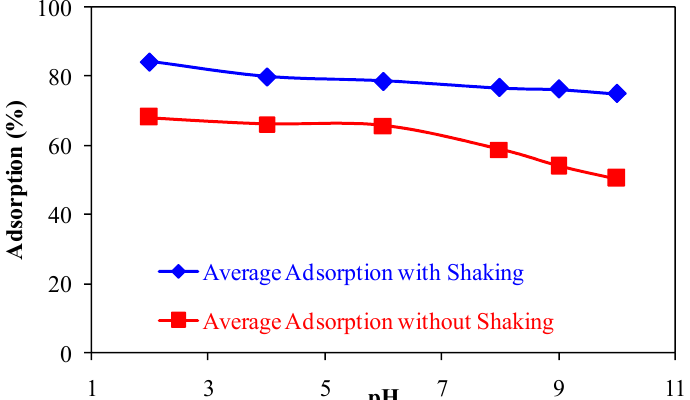
Figure 2. Effect of pH on the adsorption of RBV-5R by SCB at 20 µg/mL RBV-5R, 0.1 g SCB, and 60 min of contact time.